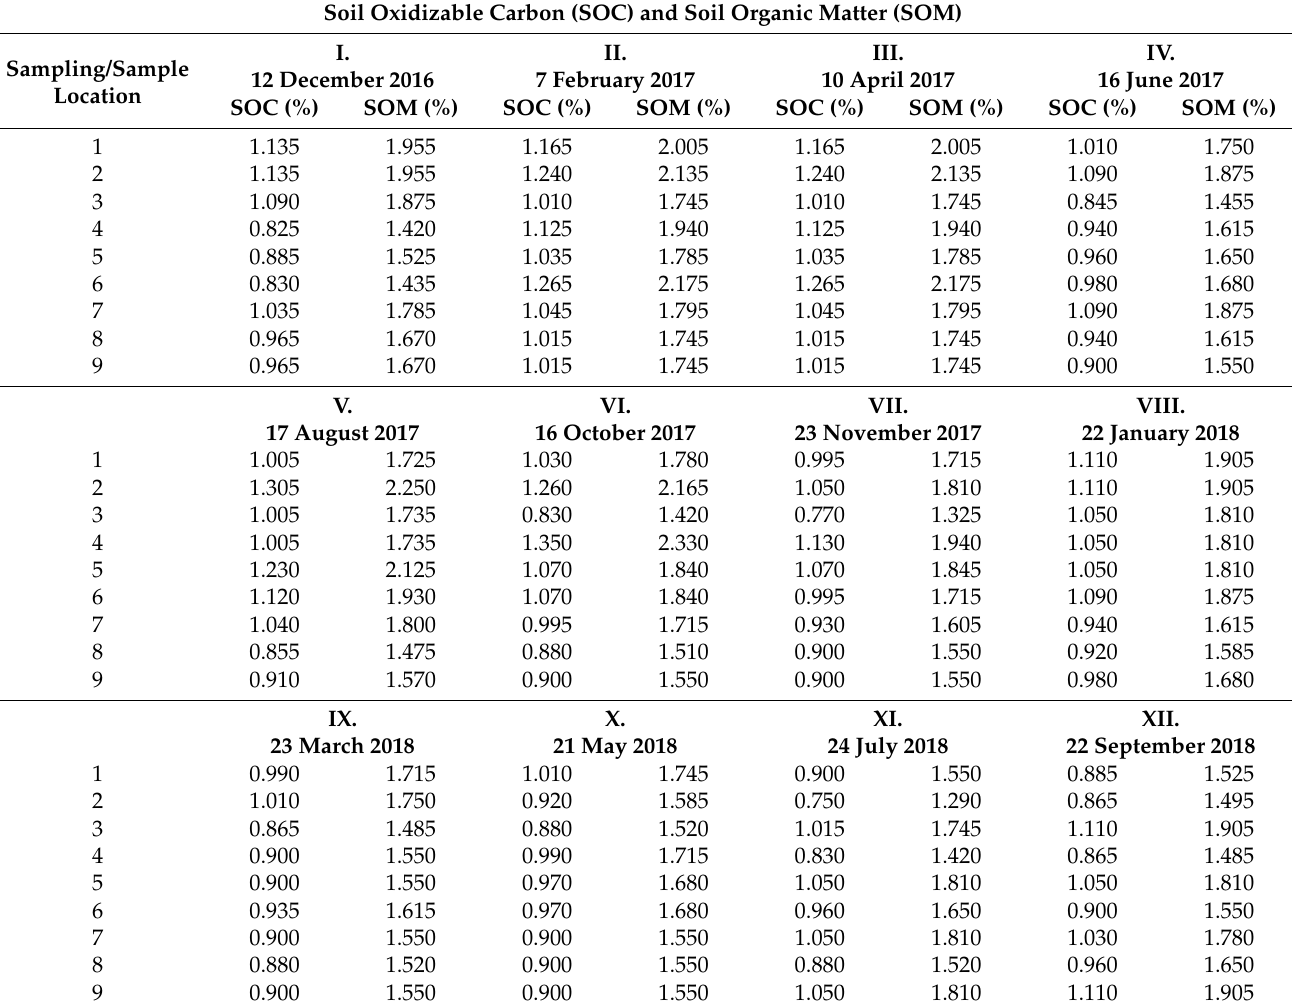
Table A2. Soil oxidizable carbon (SOC) and organic matter (SOM) content in the soil samples. Soil Oxidizable Carbon (SOC) and Soil Organic Matter